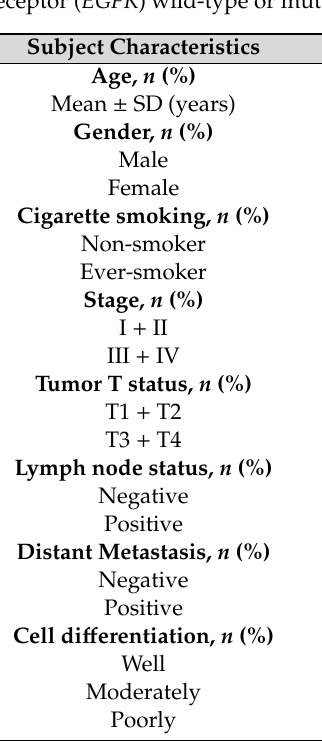
Table 1. Clinical characteristics in lung adenocarcinoma patients with the epidermal growth factor receptor ( EGFR ) wild-type or